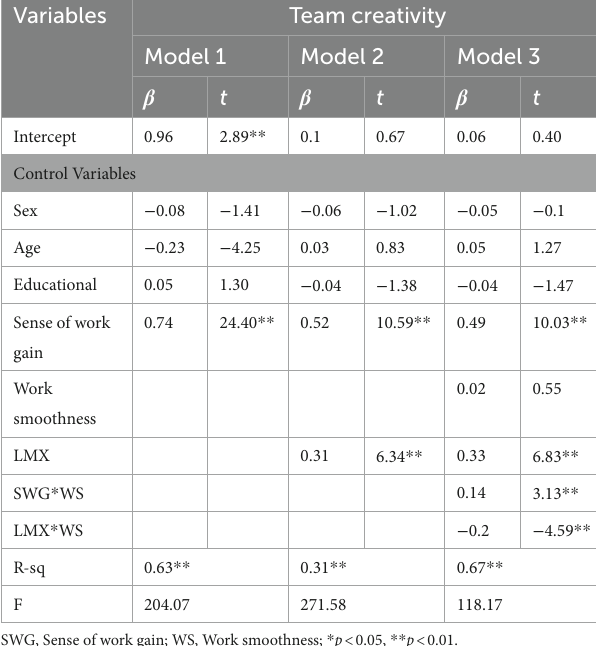
TABLE 3 Variables regression analysis.